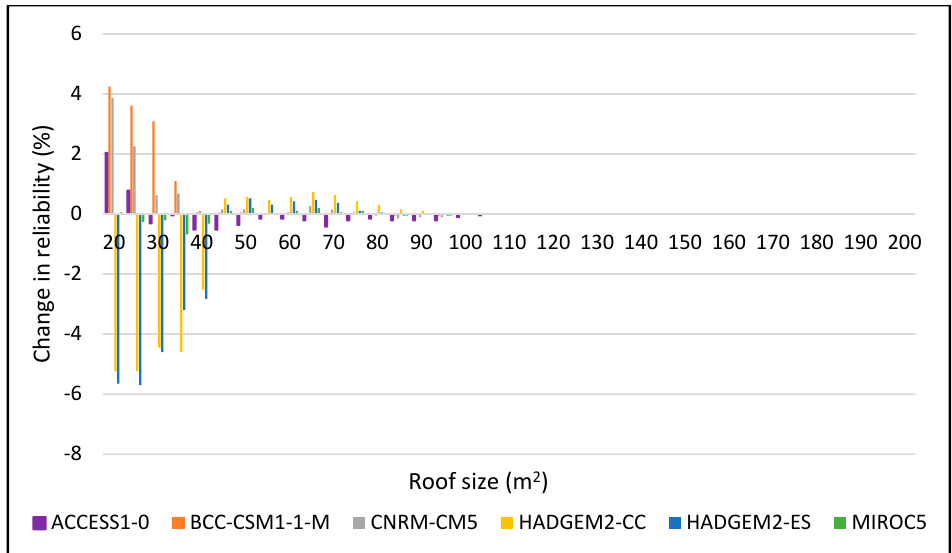
Figure 33. Change in reliability for SON season for 2025–2055 period for 5 m 3 tank size.